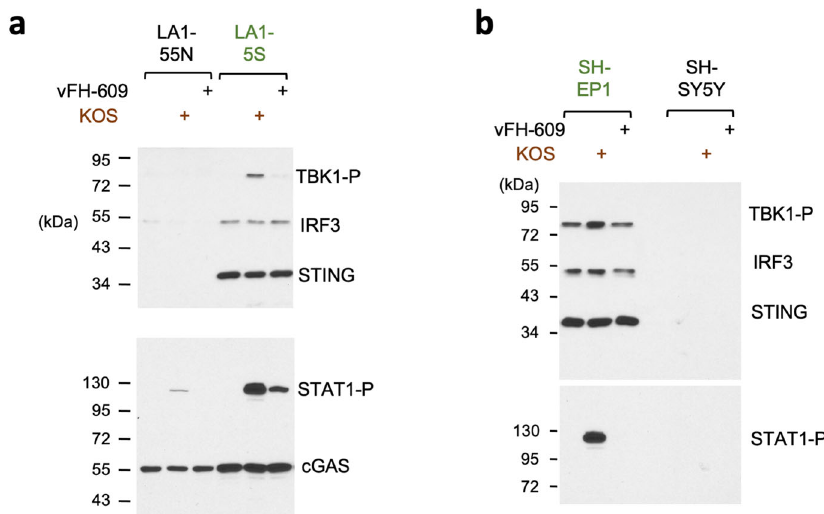
Fig. 5 Activation of the DNA sensing pathway in ADRN and MES cells by Herpes virus. a Western analysis of factors in the DNA sensing pathway in LA1-55N and LA1-5S cell lines following Herpes virus infection. b Western analysis of factors in the DNA sensing pathway in SH-SY5Y and SH-EP1 cell lines following Herpes virus